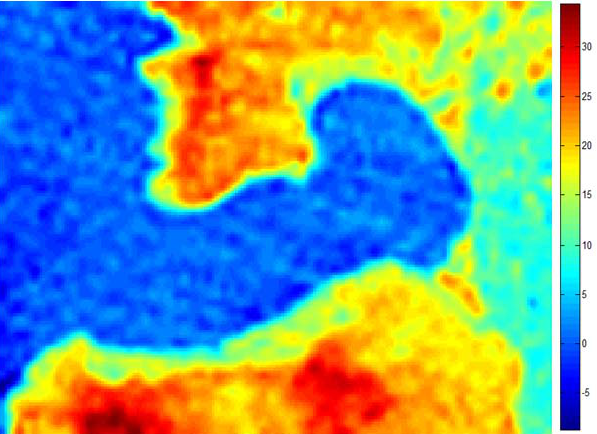
Figure 2. Land Surface Temperature image generated by split- window algorithm.